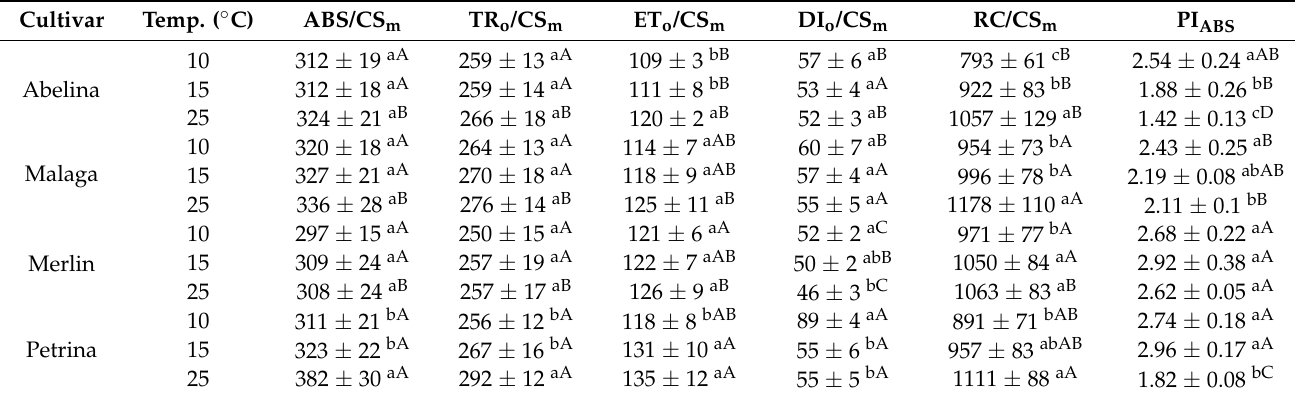
Values represent means ( n = 10) ± SE. The values of each parameter for each cultivar/temperature combination followed by the same lowercase letter and values of all cultivars at the same temperature followed by the same uppercase letter do not differ significantly according to Duncan’s multiple range test ( p < 0.05).